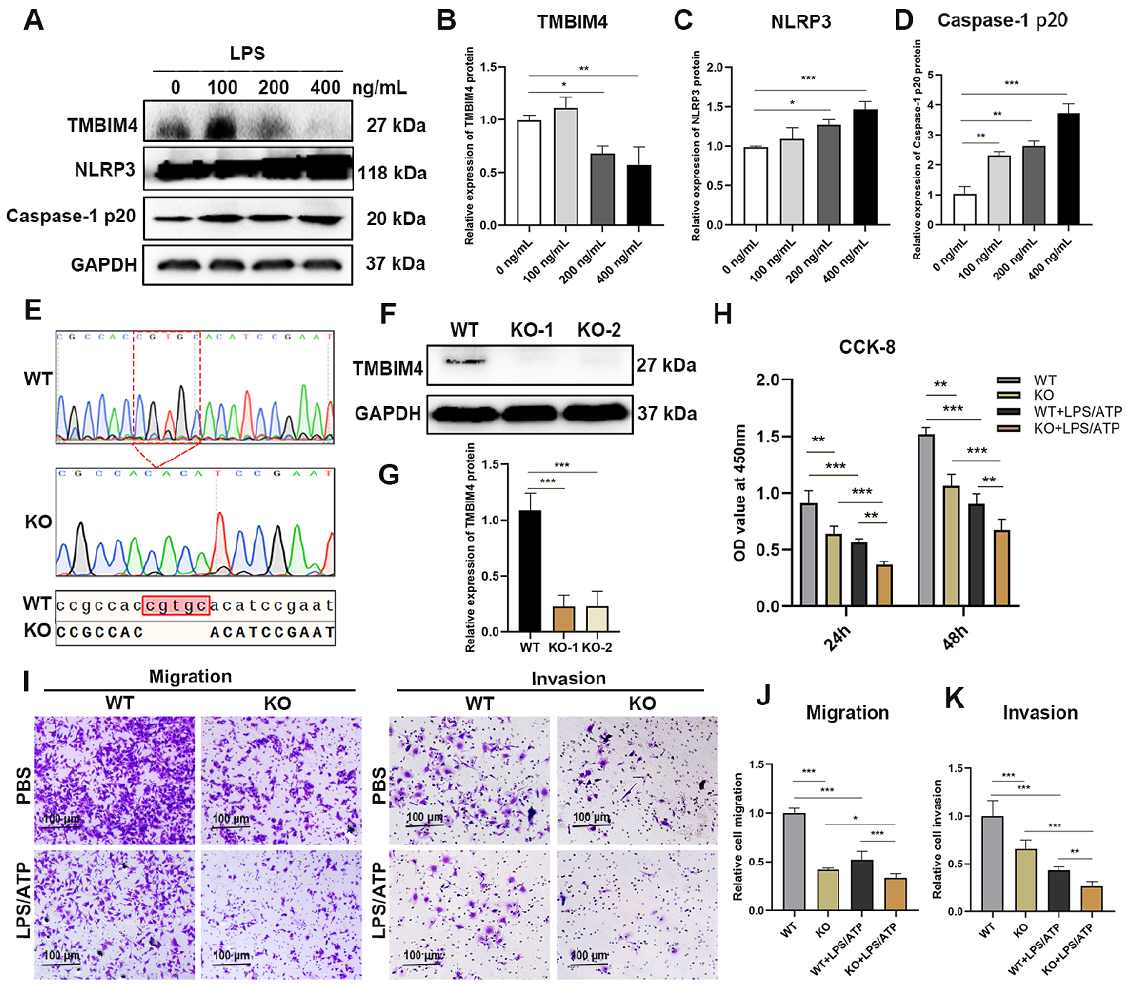
Figure 3. TMBIM4 knockout decreased the cell viability, migration, and invasion of HTR-8/SVneo cells. ( A ) HTR8/SVneo cells were treated with the indicated concentration of LPS for 48 h followed by 5 mM ATP for 45 min. Cell lysates were immunoblotted with an anti-TMBIM4 antibody, anti- NLRP3 antibody, anti-caspase-1 antibody, and anti-GAPDH antibody. ( B – D ) Graphs showing the results of quantitative densitometry analysis of TMBIM4 ( B ), NLRP3 ( C ), and caspase-1 p20 ( D ). ( E ) Representative results of DNA sequencing from TMBIM4 knockout (KO) HTR8/SVneo cells with frameshift mutations compared with wide type (WT) cells. ( F , G ) Knockout efficiency of TMBIM4 KO HTR8/SVneo cells based on immunoblot. ( H ) Viability of TMBIM4 KO cells compared to WT cells without or with LPS/ATP exposure based on CCK-8. Each assay was independently conducted at least 5 times. ( I – K ) Migration and invasive ability of WT and TMBIM4 KO stable HTR8/SVneo cells without or with LPS/ATP exposure based on the transwell assay and statistical analysis. The results are presented as mean ± SD. * p < 0.05; ** p < 0.01; ** * p < 0.001; Bar = 100 µ